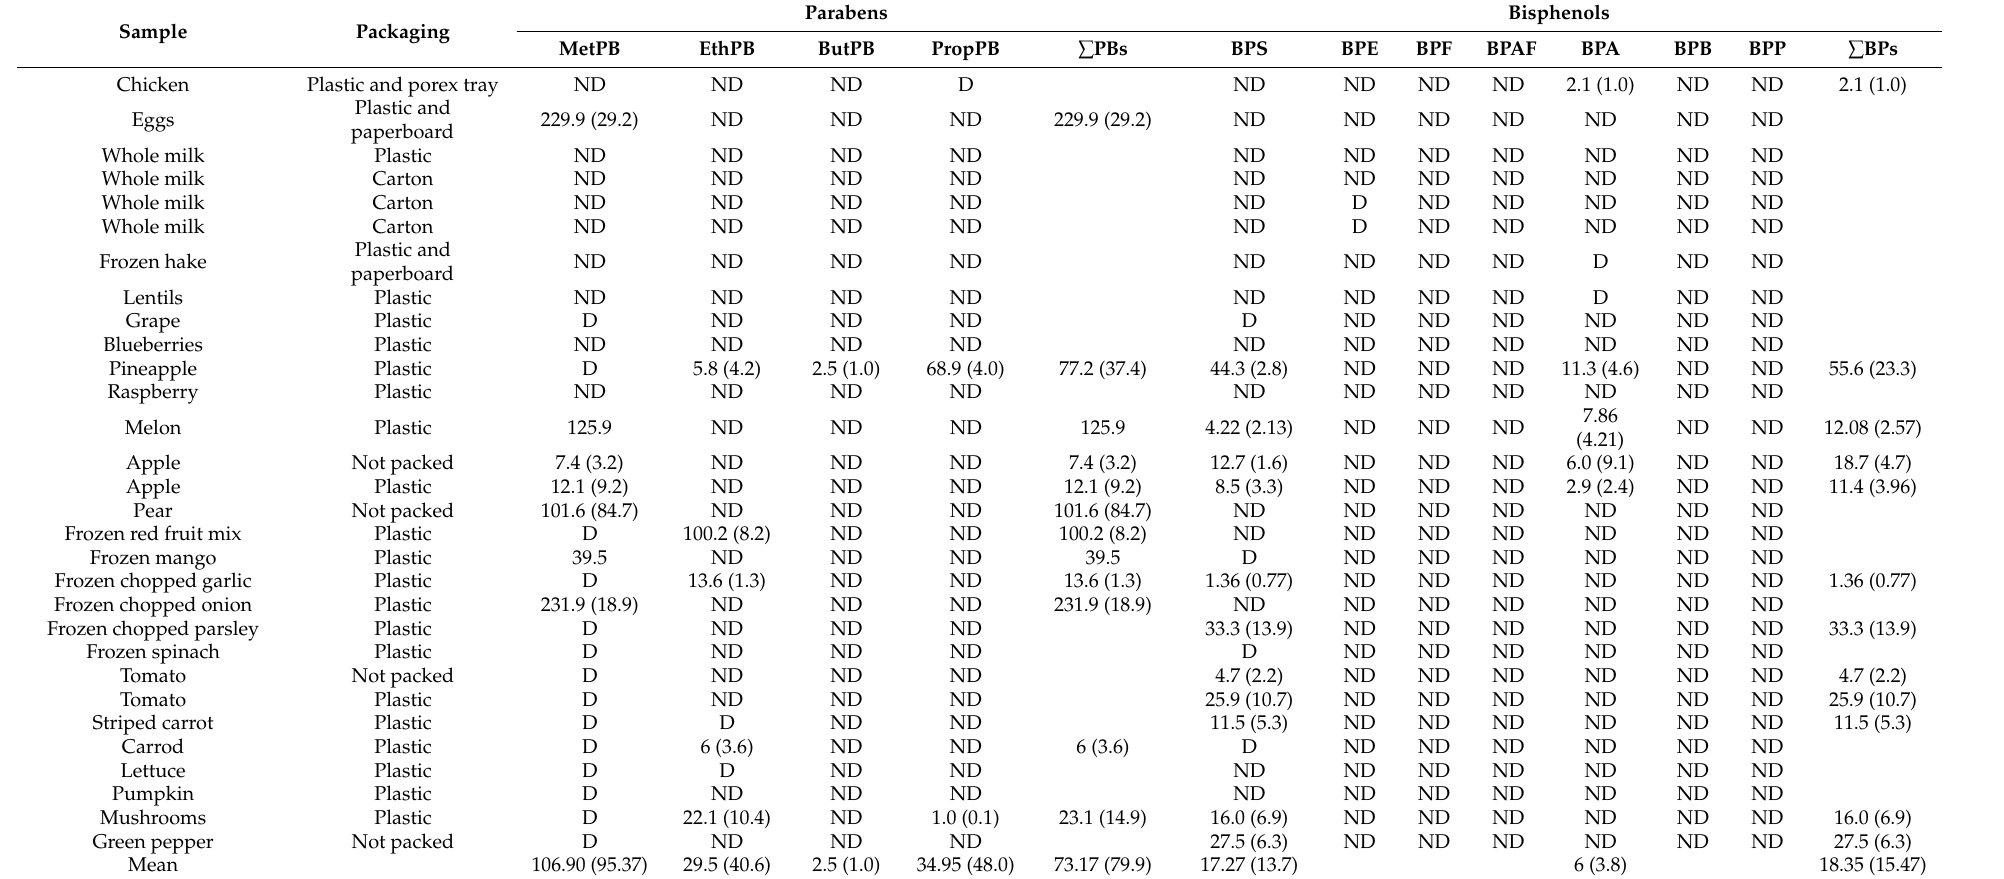
Table 4. Concentrations (ng g − 1 fresh weight) of parabens and bisphenol analogues in unprocessed or minimally processed